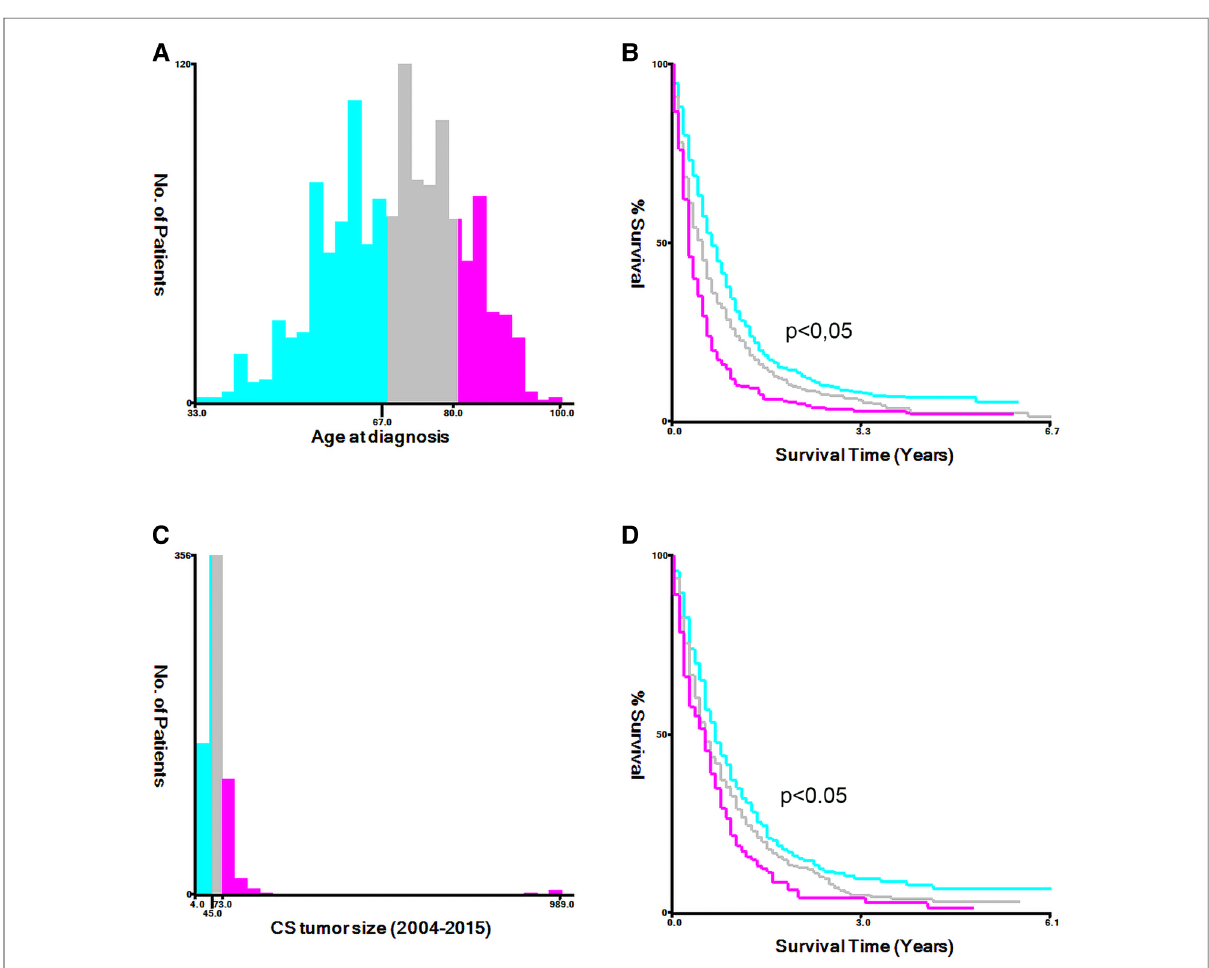
FIGURE 2 The appropriate cutoff values of age and tumor size was assessed by X-tile analysis. ( A,B ) The appropriate cutoff values of age were 67 and 80 years; ( C,D ) The appropriate cutoff values of tumor size were 45 and 73